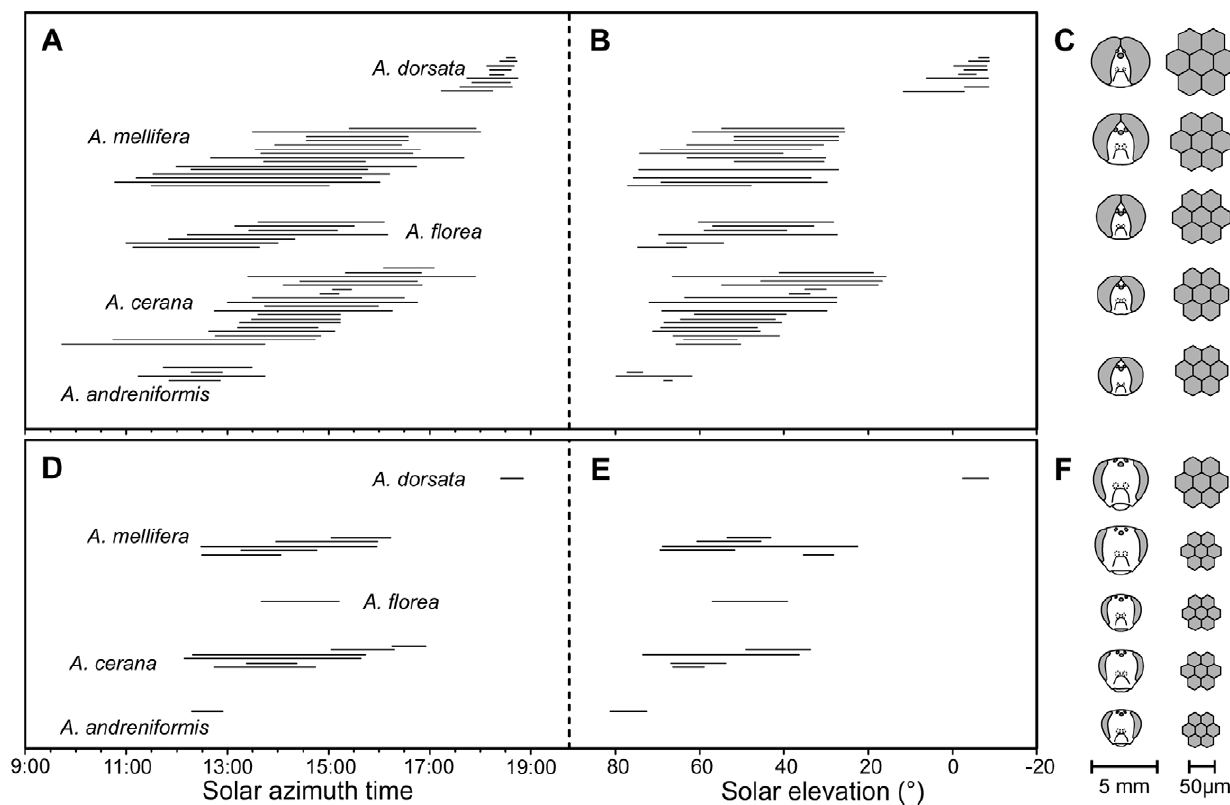
Figure 3. Species-specific mating flight activity. Drone (A, B, C) and queen (D, E, F) flight activity compiled from literature records [11,29,42,45,46,49,50,56,58–84]. (A, D) Temporal range and (B, E) corresponding solar elevation range of the flight time. When necessary, time was converted to solar azimuth time. For studies that did not report the date of observation, solar elevation could not be calculated (bars missing in B, E). (C, F) Graphical representation of the heads (left) and ommatidia diameters (right) for all species (scale bars below). Species are sorted in an ascending order of drone eye size, ommatidia and ocellar diameters.